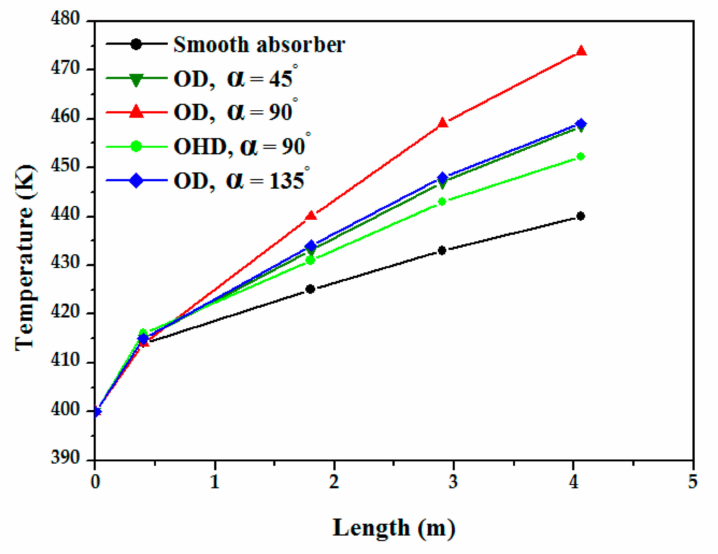
Figure 10. Variation in absorber tube’s average temperature and without obstacles (Re = 44007, v = 0.35